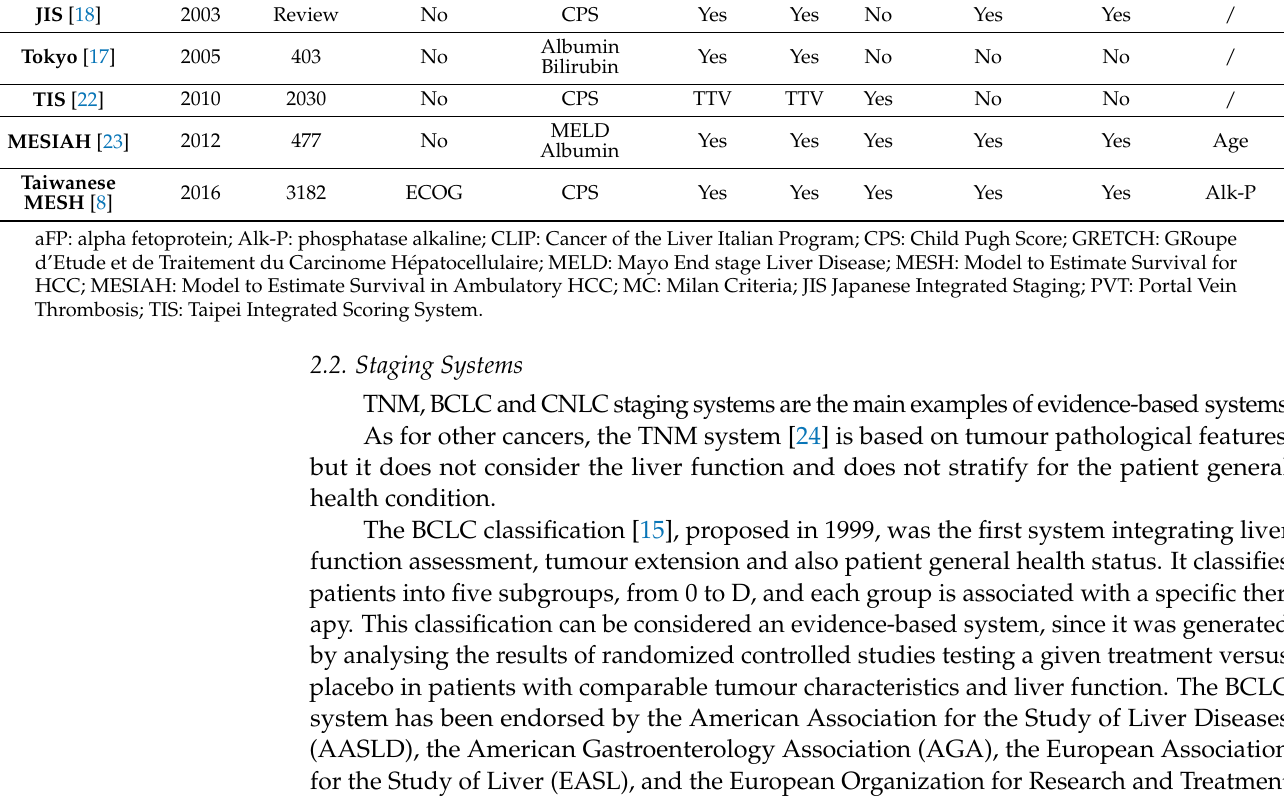
Table 1. MESH score and its associated variables. Prognostic Factors Tumour burden Within MC Beyond MC Vascular invasion or metastases Absent Present